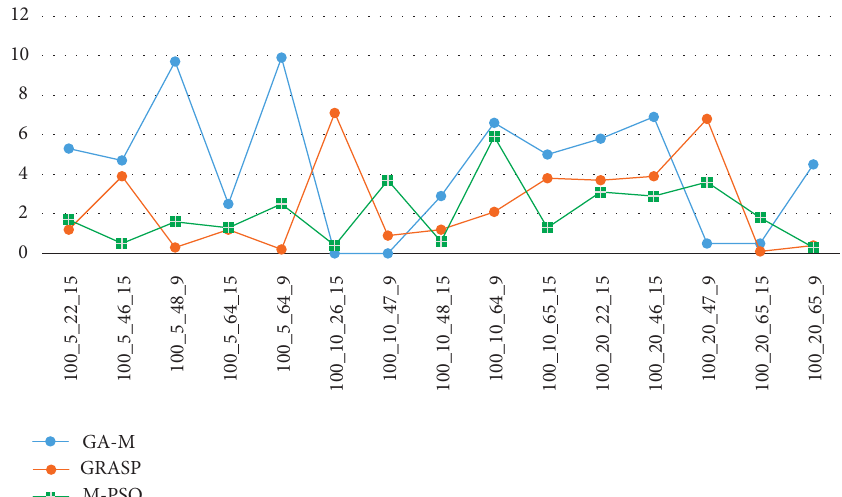
Figure 9: Comparing STD values between GA-M, GRASP, and M-PSO of 100 tasks